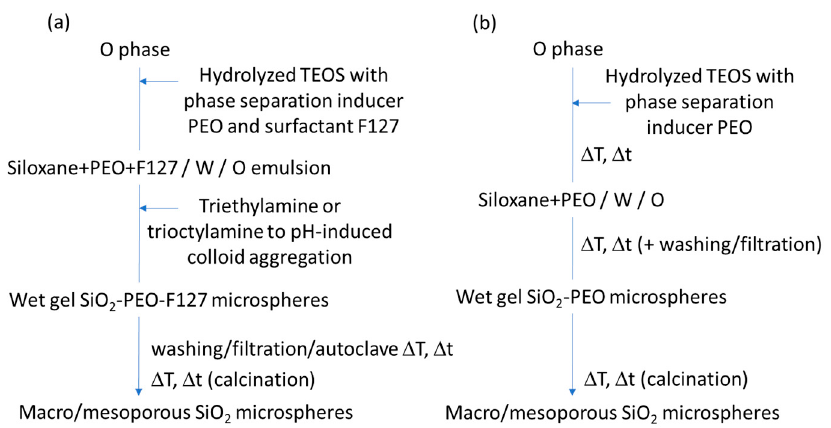
Figure 23. Representative synthesis flowcharts, employing W/O emulsification as soft template, and sol-gel/phase separation, for the achievement of macro/mesoporous SiO 2 microspheres: ( a ) method developed by Yang et al. [127]; ( b ) method developed by Shi et al. [112]. The O phase is composed by paraffin oil and Span 80. (Marques et al., original schemes).